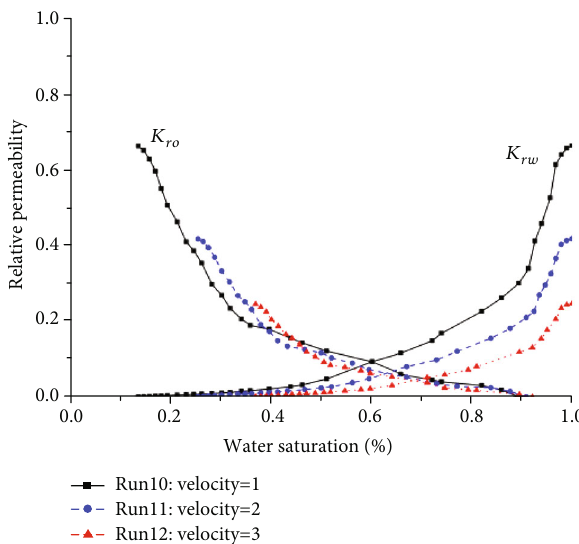
Figure 11: E ff ect of brine viscosity on relative permeability.